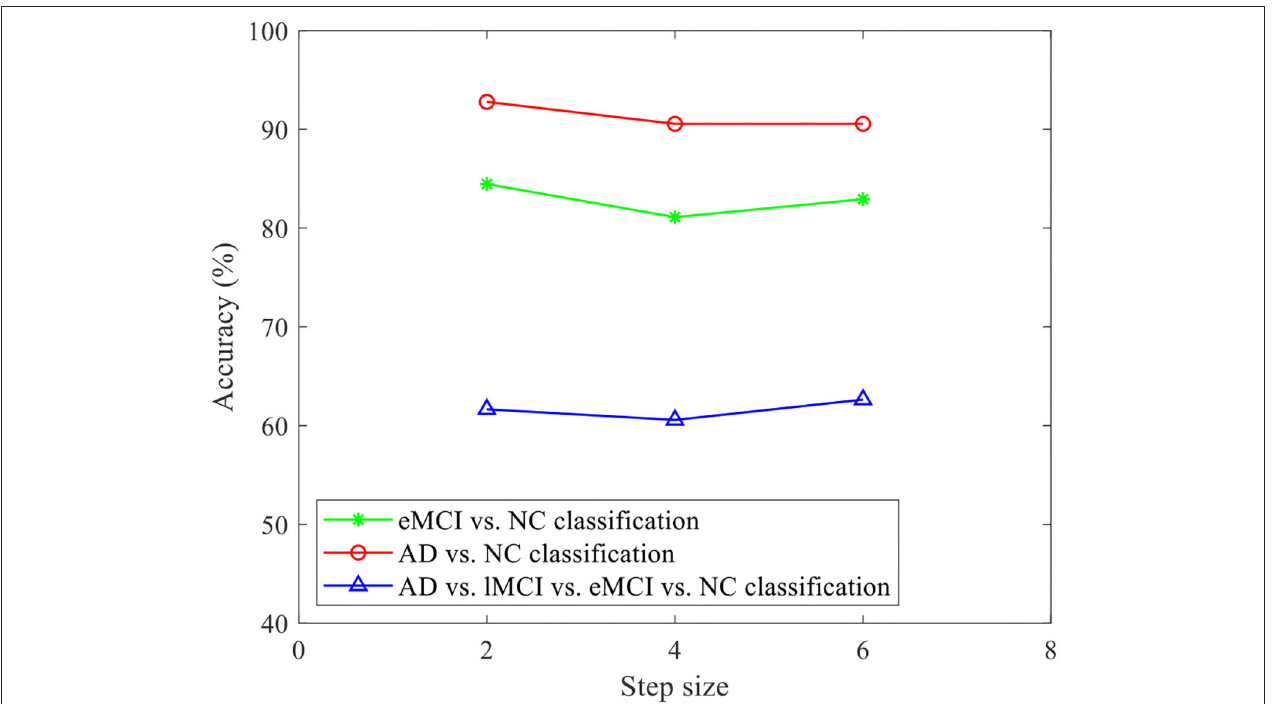
FIGURE 10 | Accuracy of the proposed CRNN method with different stride sizes on three classification tasks (i.e., eMCI vs. NC, AD vs. NC, and AD vs. lMCI vs. eMCI vs. NC classifications).